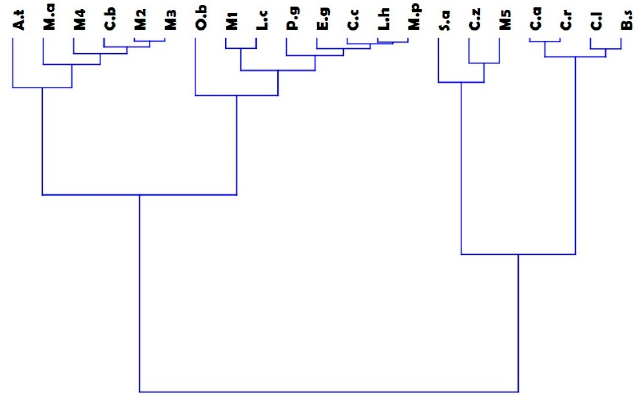
Figure 1. Dendrogram of the Hierarchical Cluster Analysis (HCA) of both essential oils and mixtures.